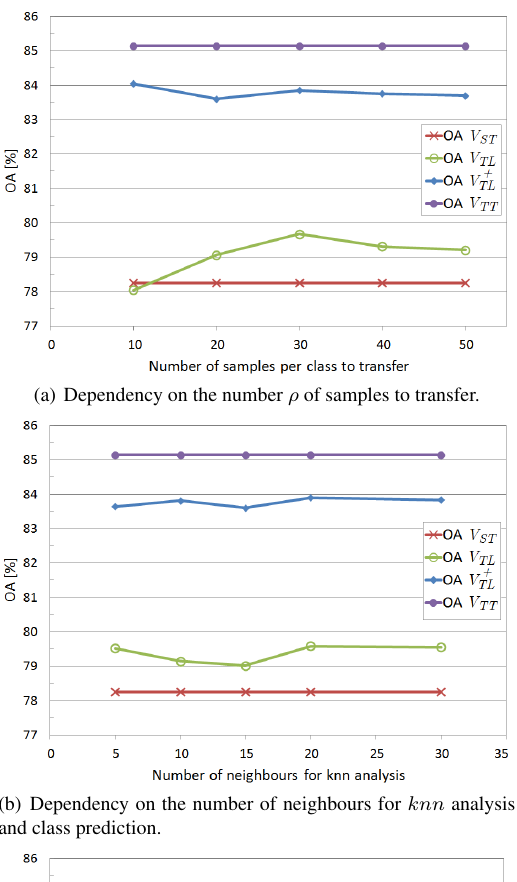
Figure 4: Reference data and results of classification of the tar- get area for test pair 30 = 34 for the three classification variants. Colours: ground (white), building (blue) and tree (green).